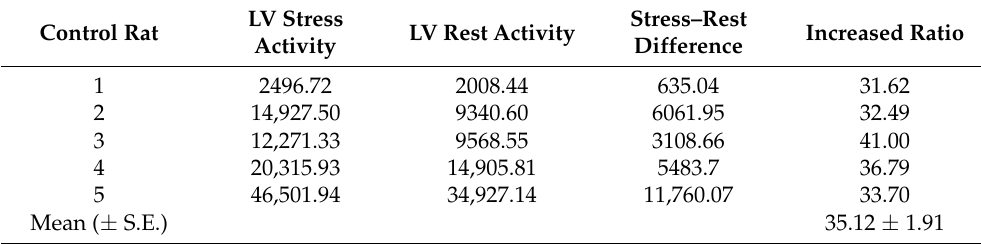
Table 2. Tracer activity (Bq/mL) in the segmented LV intra-myocardial vascular volume in stress and rest conditions and relative percentage stress-related increase in LV intra-myocardial vascular volume (“stress–rest difference”) after regadenoson injection in the control rats. Stress–rest difference is calculated on a pixelwise level, as detailed in the Materials and Methods section.